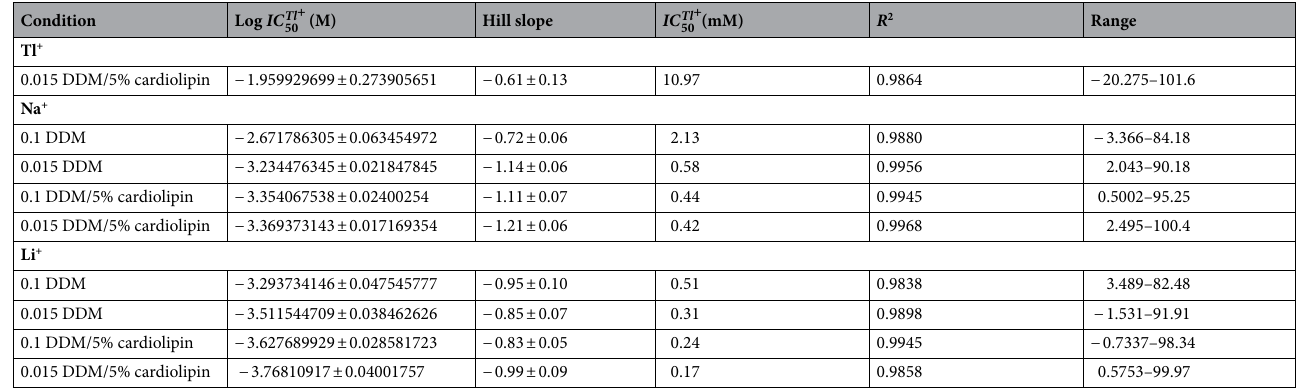
Table 1. Summary of nonlinear regression fitting to obtain the (apparent) affinities for Tl + , Na + , or Li +